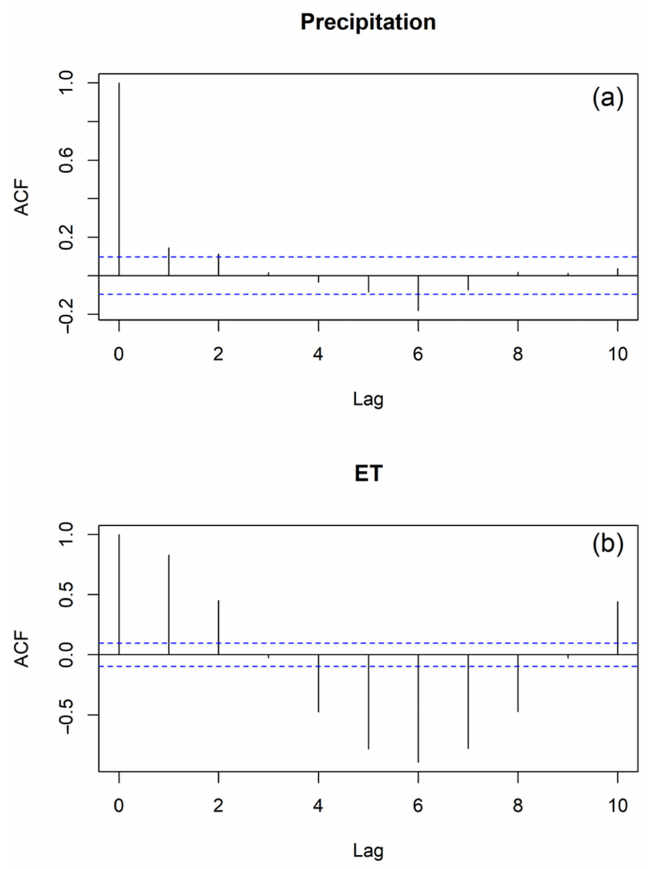
Figure 2. Autocorrelation Functions (ACF) plots for ( a ) PPT and ( b ) PET.